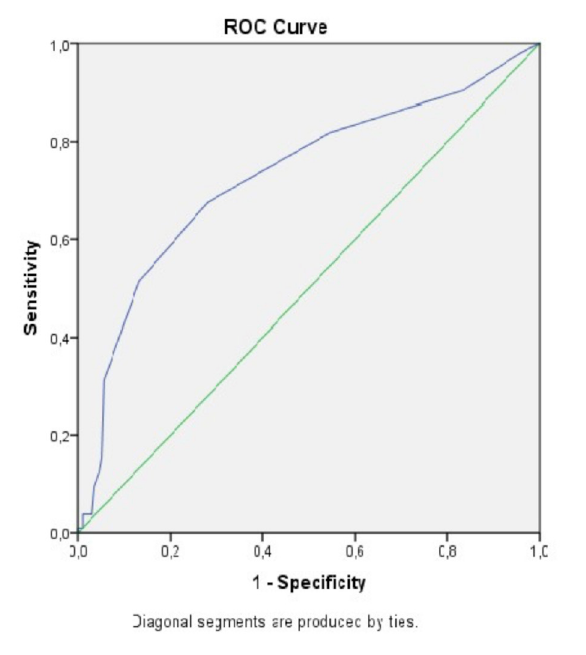
Fig. 2 – Red cell distribution width platelet count ratio .